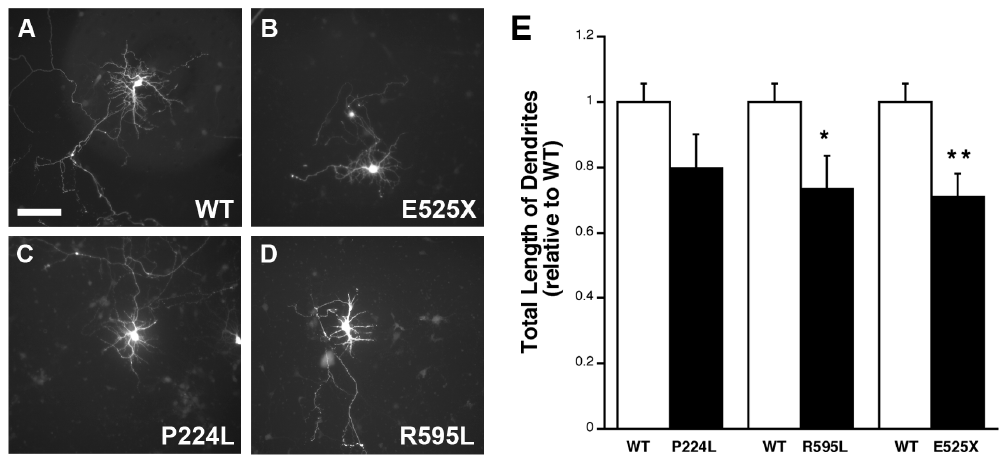
Figure 7. Hippocampal cells transfected with VGF SNP plasmid exhibit shorter neurites. ( A – D ) Representative images of hippocampal cells transfected with plasmids containing either WT VGF ( A ) or VGF SNPs E525X ( B ), P224L ( C ), R595L ( D ) from 4–7 DIV, Scale bar = 80 µm; and ( E ) bar graphs represent average total length of dendrites normalized to WT neurons ± SEM as quantified using NeuronJ. ( n = 7, 8), Two-sample t test: WT vs. P224L t(17) = − 0.166, p = 0.114. WT vs. R595L t(16) = − 0.789, p = 0.038. WT vs. E525X t(12) = − 1.36, p = 0.006. * p < 0.05, unpaired t -test, ** p < 0.01, unpaired t -test.